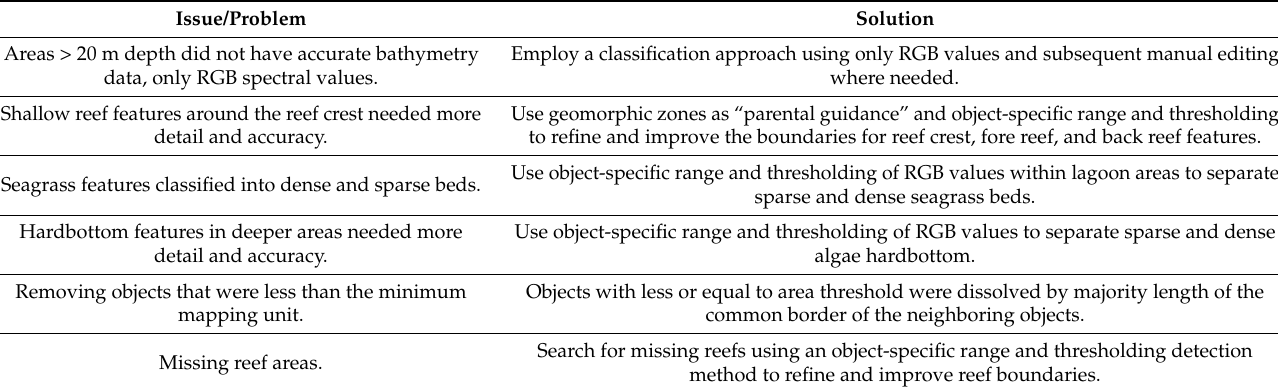
Table 3. Issues/problems encountered during the development of the eCognition classification approach and corresponding solutions